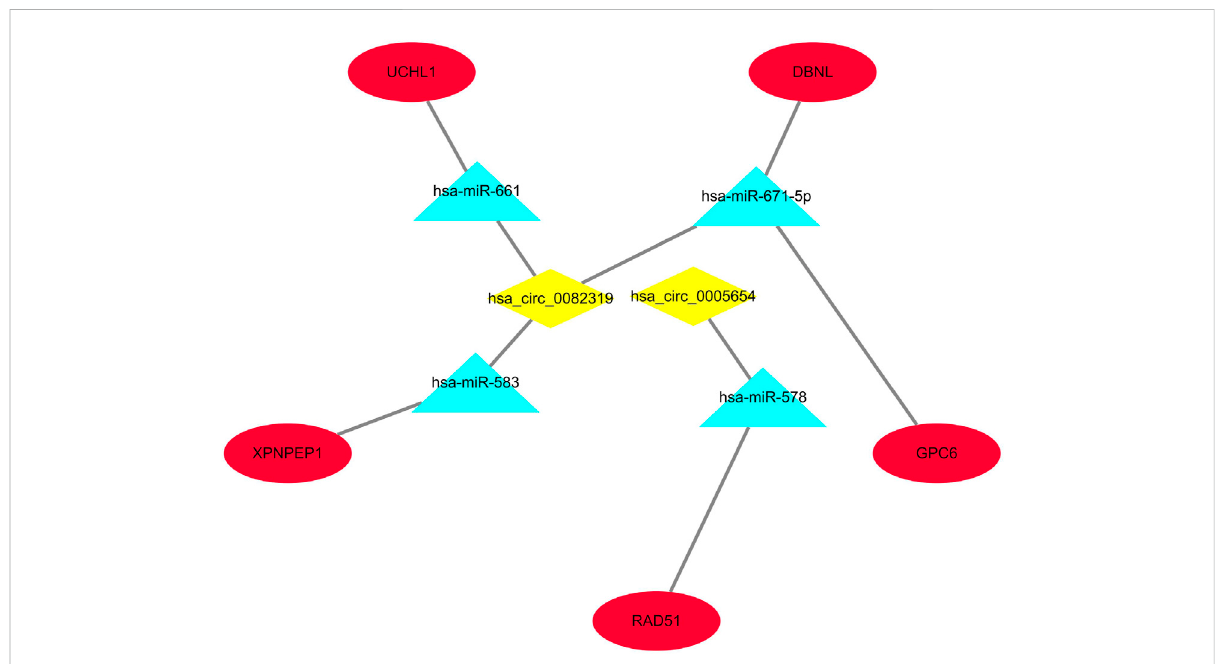
FIGURE 4 The visualized ceRNA regulatory network was constructed by Cytoscape software. The diamond represents 2 downregulated circRNAs, the triangle represents 4 upregulated miRNAs and the ellipse represents 5 downregulated